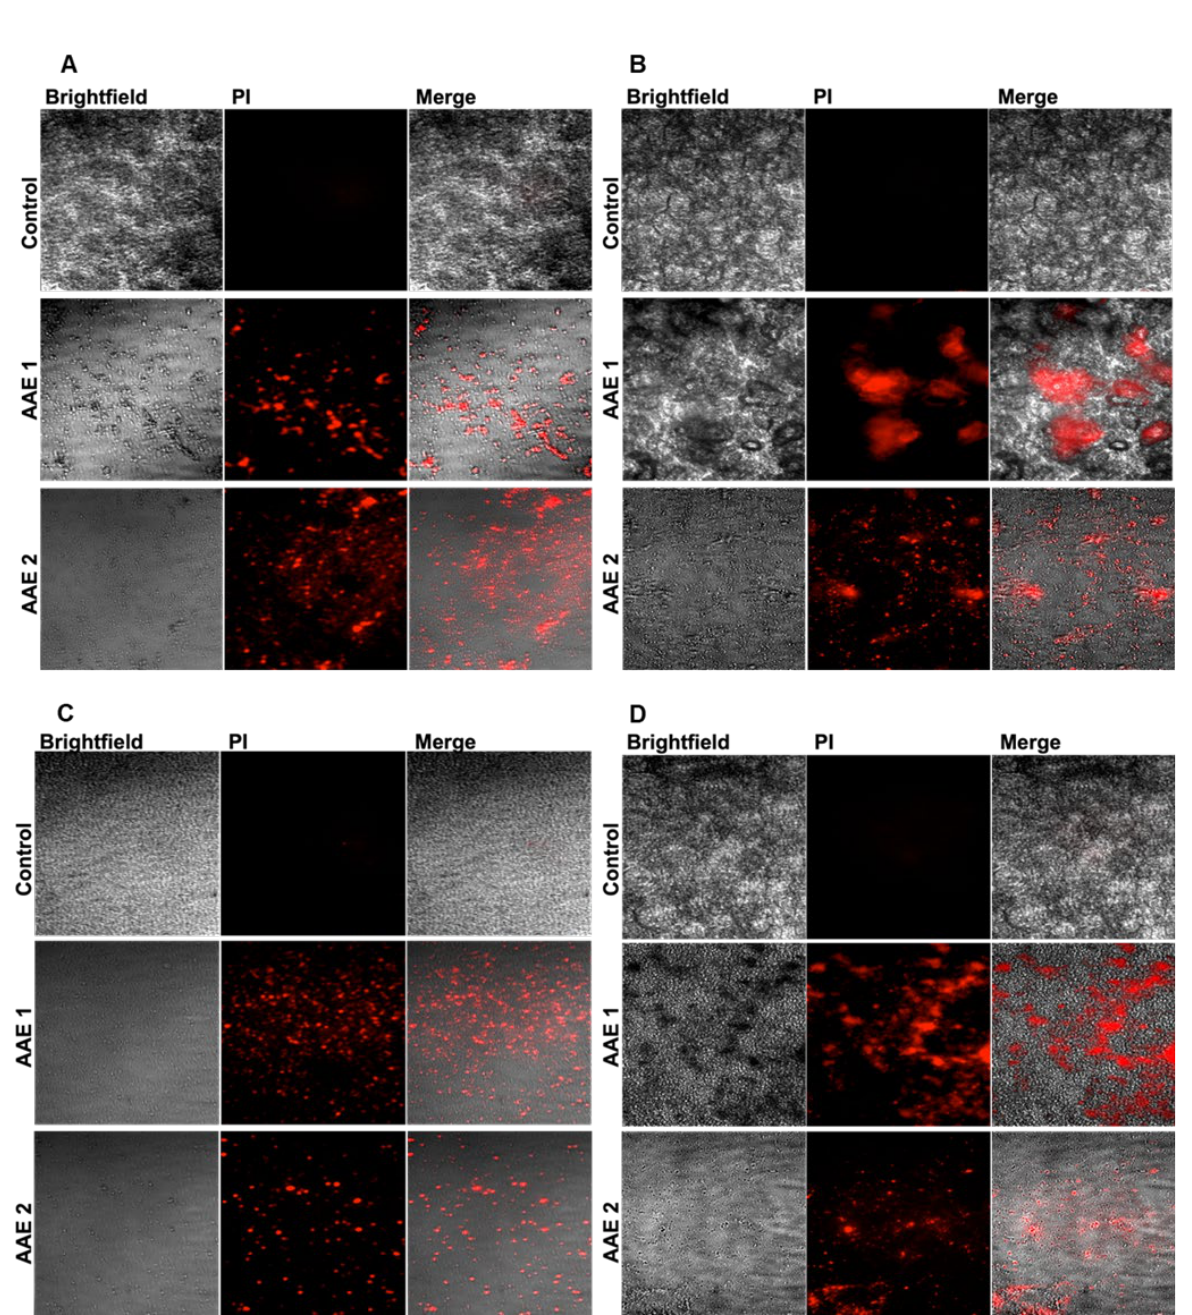
Figure 3. AAE demonstrates microbial death against ( A ) C. albicans , ( B ) E. faecalis , ( C ) MRSA, and ( D ) K. pneumoniae .